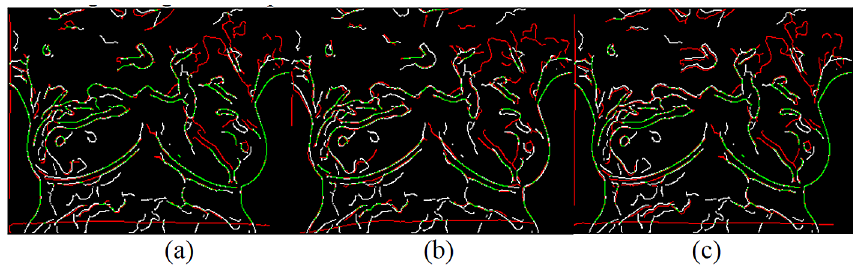
Figure 9. Canny overlays of TYPE I images obtained with ( a ) the proposed ( b ) Lee et al . ( c ) Optical flow.